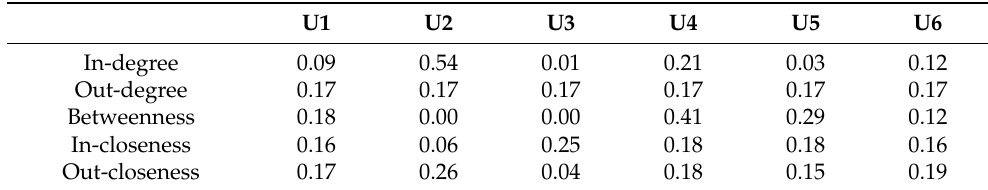
Table 7. Centrality measurements in the network of habitats visited by wild boar individuals. (Symbols in the top row explained in Table